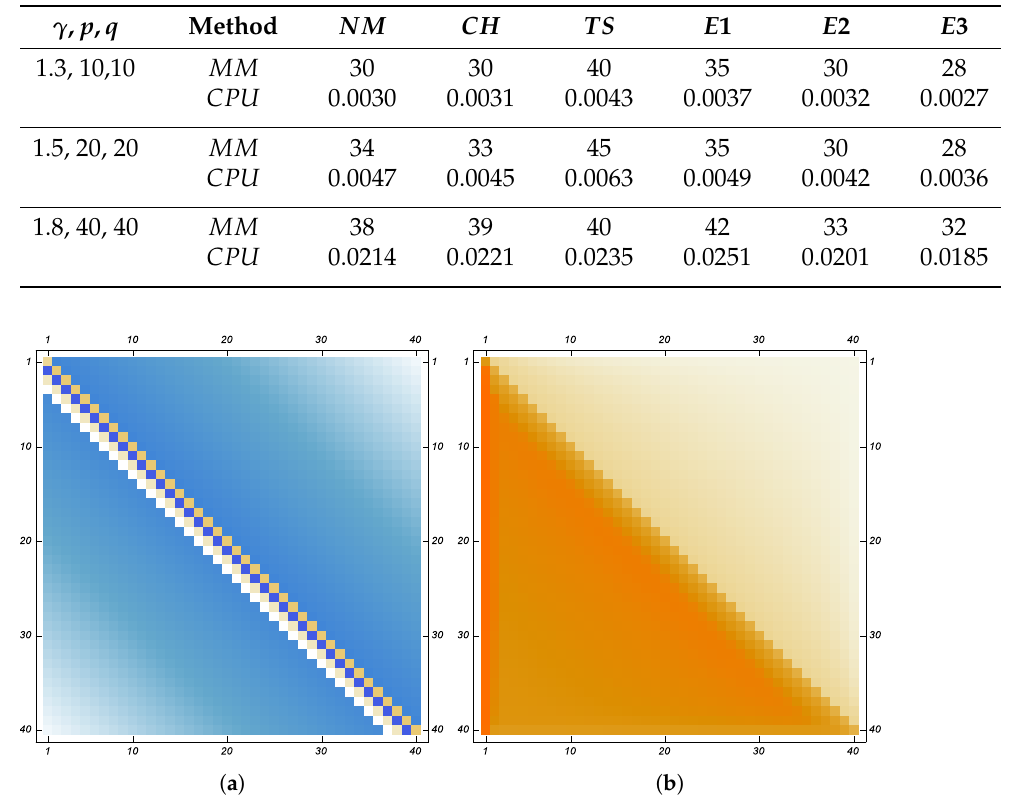
Table 11. Results of Example (8).